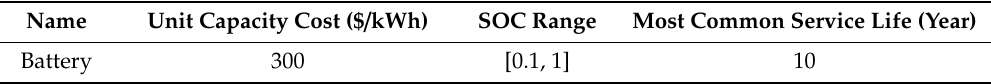
Table 2. The battery parameters.